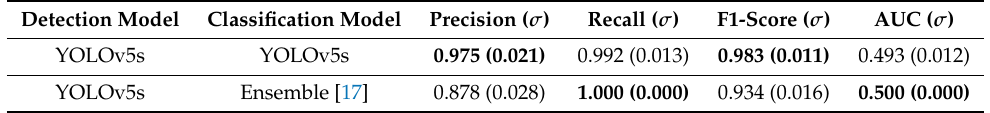
Table 5. Results of the whole image